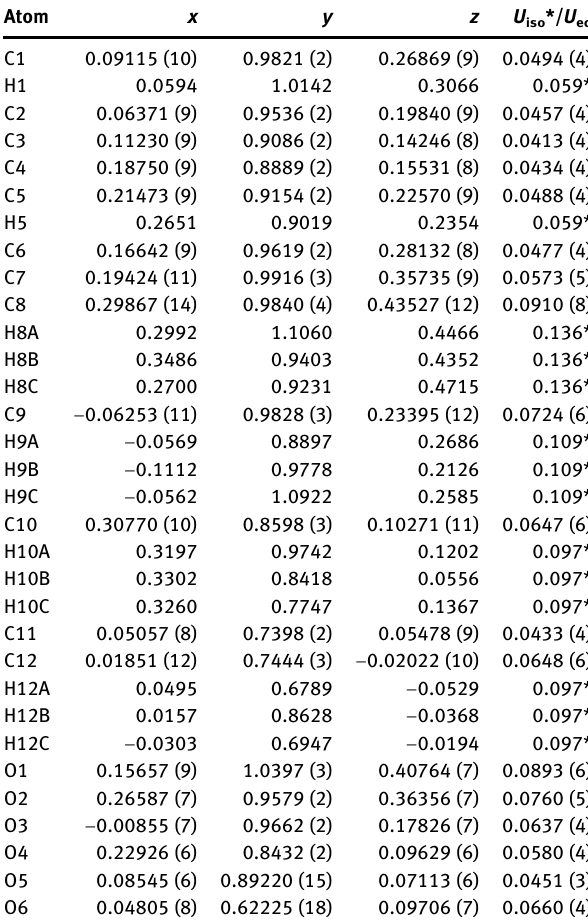
Table  : Fractional atomic coordinates and isotropic or equivalent isotropic displacement parameters (Å 